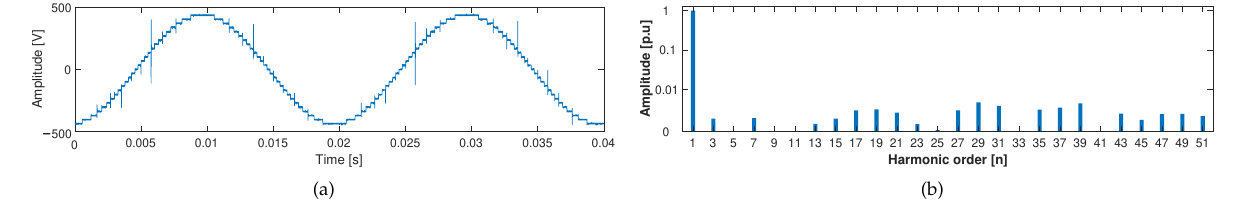
Figure 11. Waveforms: ( a ) Experimental output voltage for traditional nearest level control, ( b ) voltage harmonic spectrum for nearest level control.